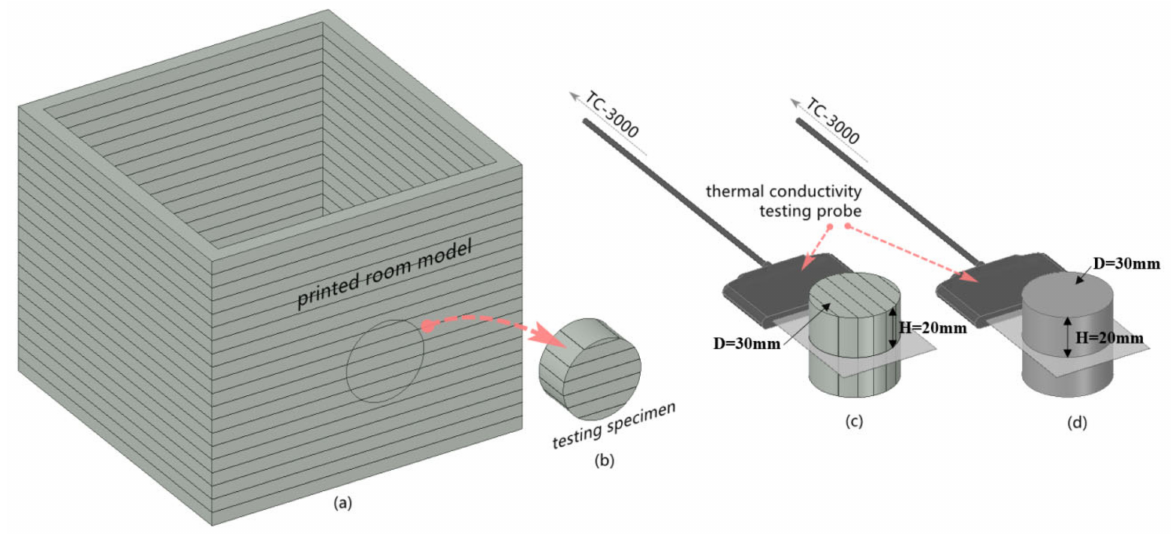
Figure 6. Thermal conductivity tests: ( a ) CAD sketch of the printed room; ( b ) testing specimen from the room model; ( c ) printed specimen tested with TC-3000; and ( d ) cast specimen tested with TC-3000.